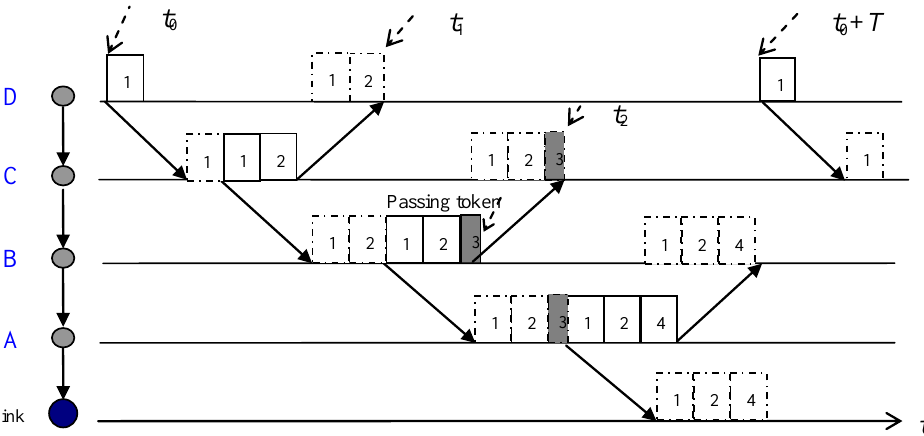
Figure 6. Data packet transmission via an established path.